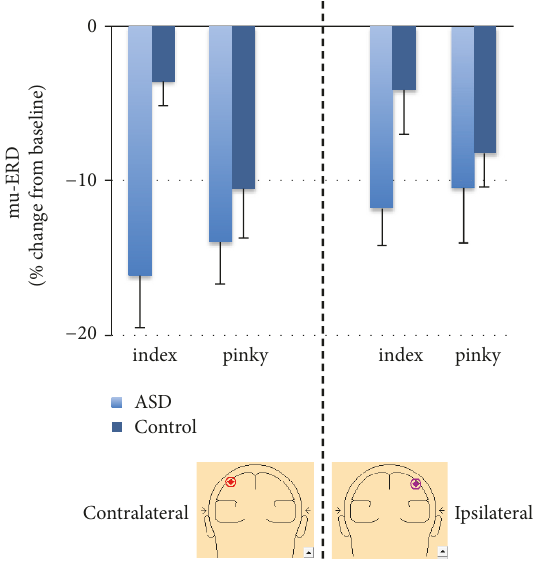
Figure 4: Children with ASD exhibit greater mu-ERD than their control peers. Mean (+/- sem) mu rhythm ERD to Index and Pinky Imitation from virtual electrodes contralateral (left) and ipsilateral (right) to right hand of participant.